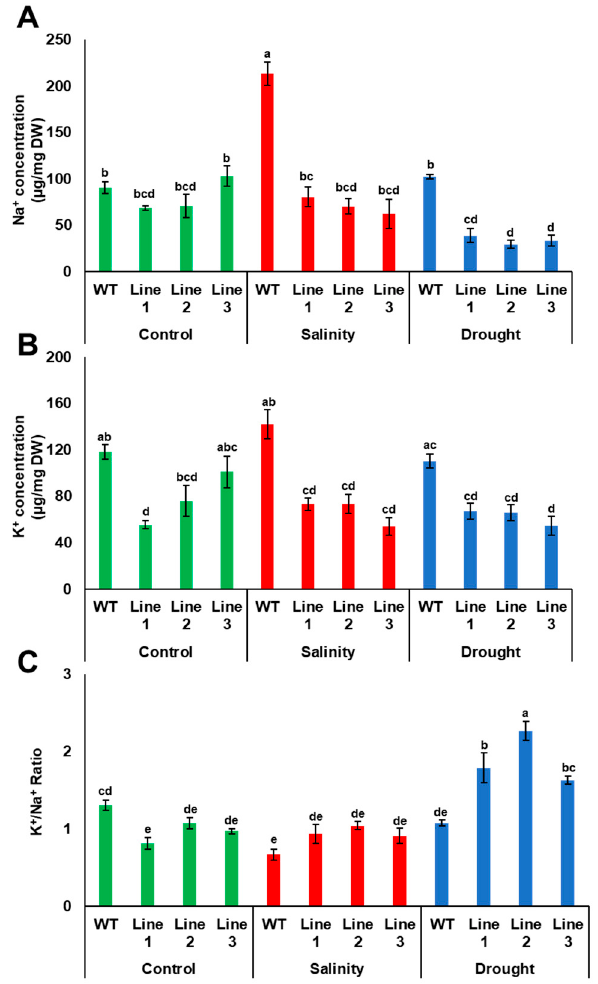
Figure 9. Accumulation of Na + and K + in transgenic Arabidopsis plants. Na + ( A ) and K + ( B ) concentrations and the K + / Na + ratio ( C ) in WT and transgenic Arabidopsis lines with PdPIP1;2 subjected to drought (150 mM mannitol) and salinity (100 mM NaCl) on half-strength MS medium plates. The bars represent the mean concentrations of Na + and K + ( ± SE, n = 3), while the asterisks indicate a significant difference to WT at p < 0.05.